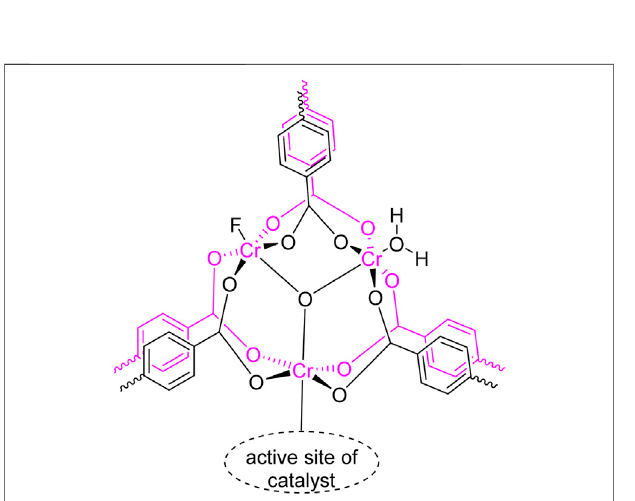
FIGURE 3 | Proposed structure for the active site of the MIL-101(Cr) catalyst.